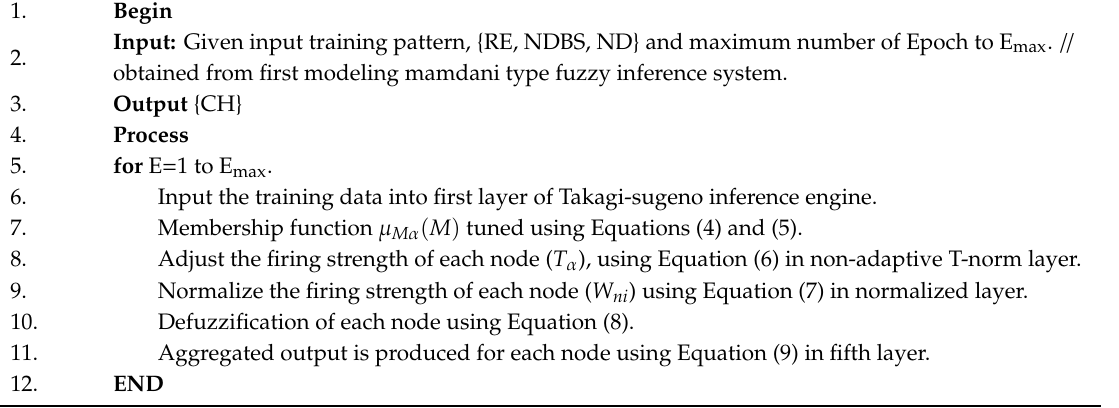
Algorithm 1- Adaptive Neuro Fuzzy Clustering Algorithm